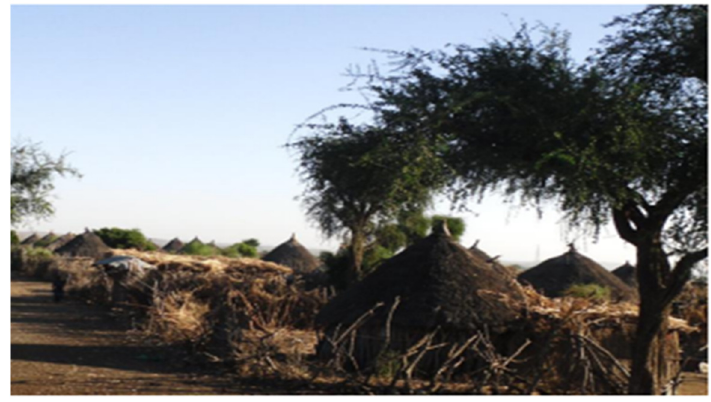
Figure 5. Thatch village.